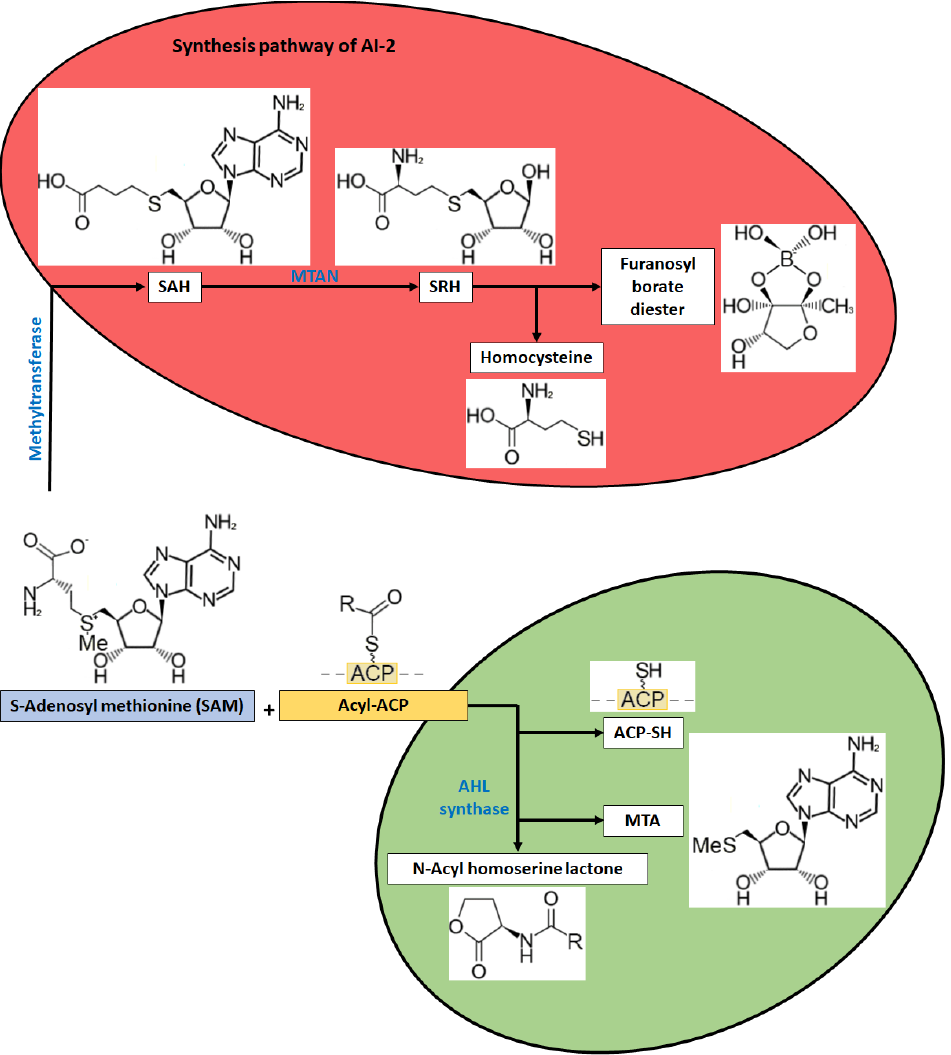
Figure 2. Schematic of the biosynthetic pathway of Al-1 and Al-2 signaling molecules. SAM-S- adenosyl-L-methionine, MTA-5’-methylthioadenosine nucleosidase, MTAN-5’-methylthioadenosine nucleosidase, SAH-S-adenosylhomocysteine, SRH-S-ribosylhomoserine (SRH).